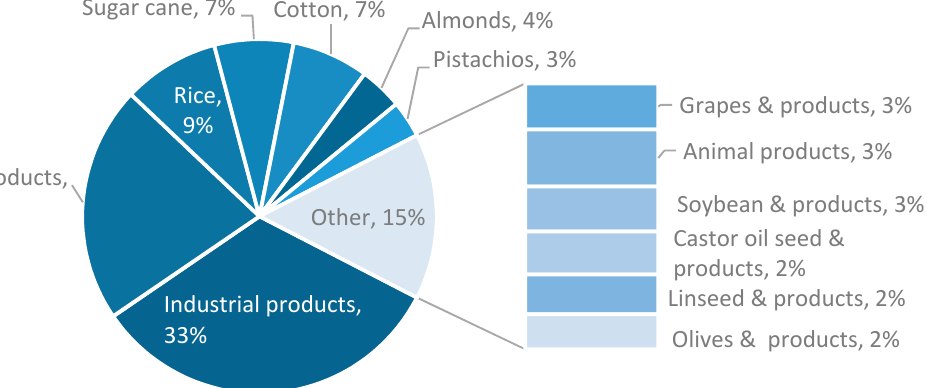
Figure 3. Blue virtual water import to the EU by product group, average for 2006–2013. More than 90% of total green virtual water import to the EU are from Brazil, Argentina, Ivory Coast, Ghana, Indonesia and Malaysia and is related to the import of crop products (Figure 4). More than half of the total virtual water import from the USA is from crop products, with the largest share being the green water footprint (52%) followed by the grey (35%) and blue (15%) water footprint components.